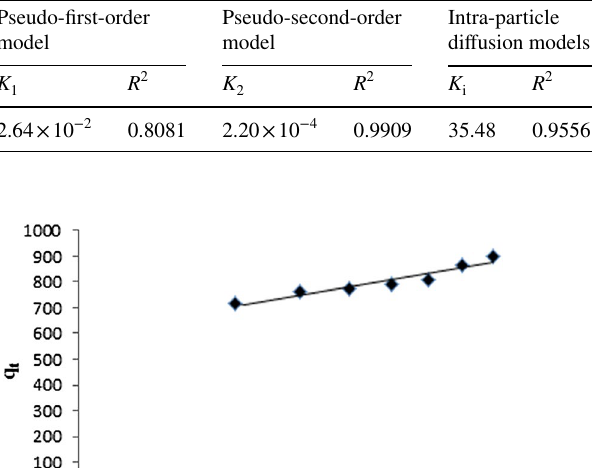
Table 2 Kinetic parameters for pseudo-first-order, pseudo-second- order, and intra-particle diffusion models Pseudo-first-order model